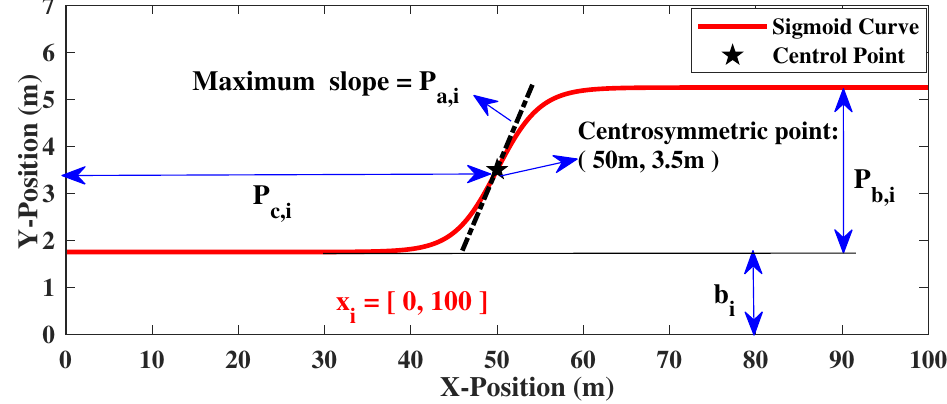
Figure 8. The parameters of sigmoid